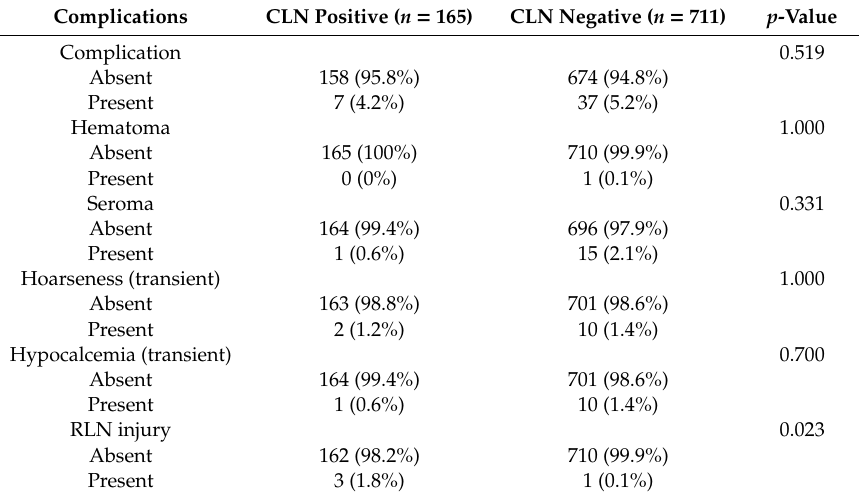
Table 4. Postoperative complications of the CLN-positive and CLN-negative groups.